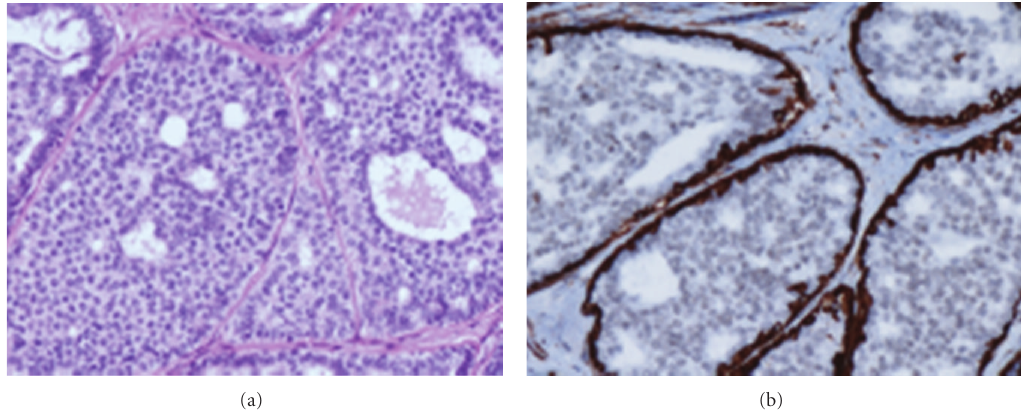
Figure 3: H.E and immunoreaction for SM-actin—low grade ductal in situ carcinoma (DIN1c). Cribriform type of intraductal proliferation with round, regular lumina, monomorphic round nuclei. Myoepithelial cells surround the duct but are not in the proliferation.